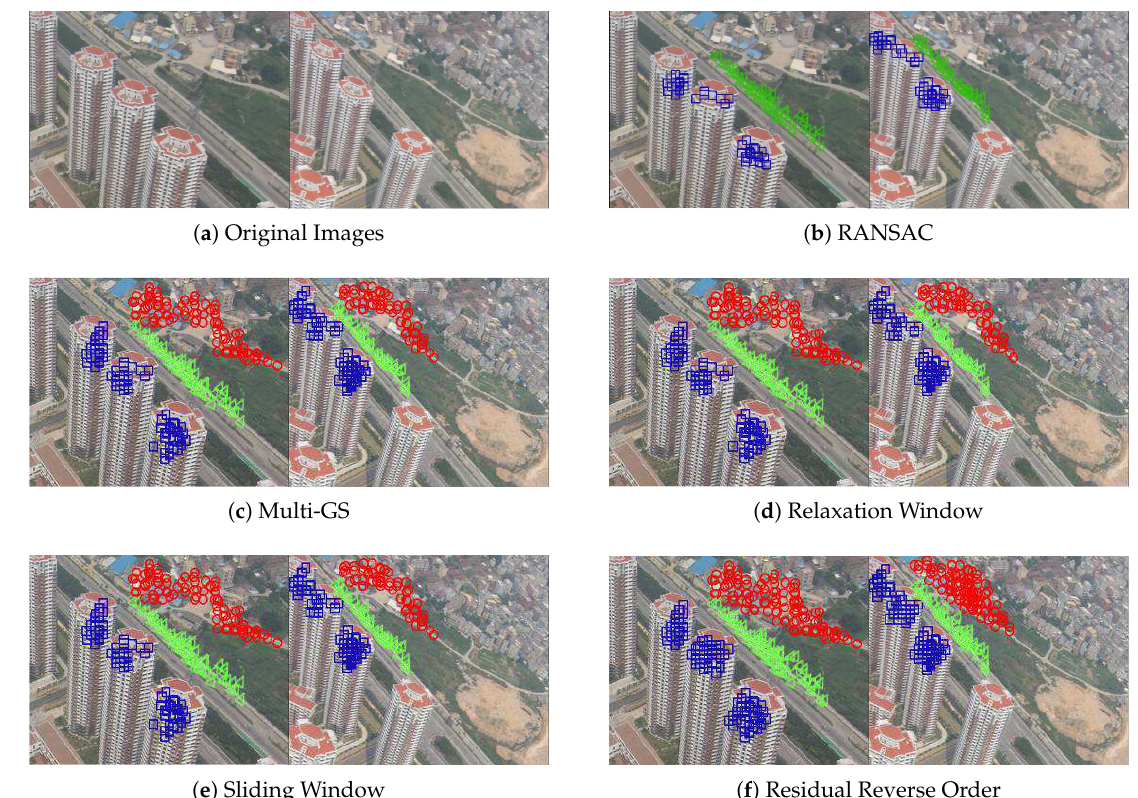
Figure 5. The three-homographic matrices extracted results from image pair of Apartments 1 , where green triangles, blue squares, and red circles represent the extracted inliers (correct matched features) that located on road, high rise buildings, and low rise buildings,